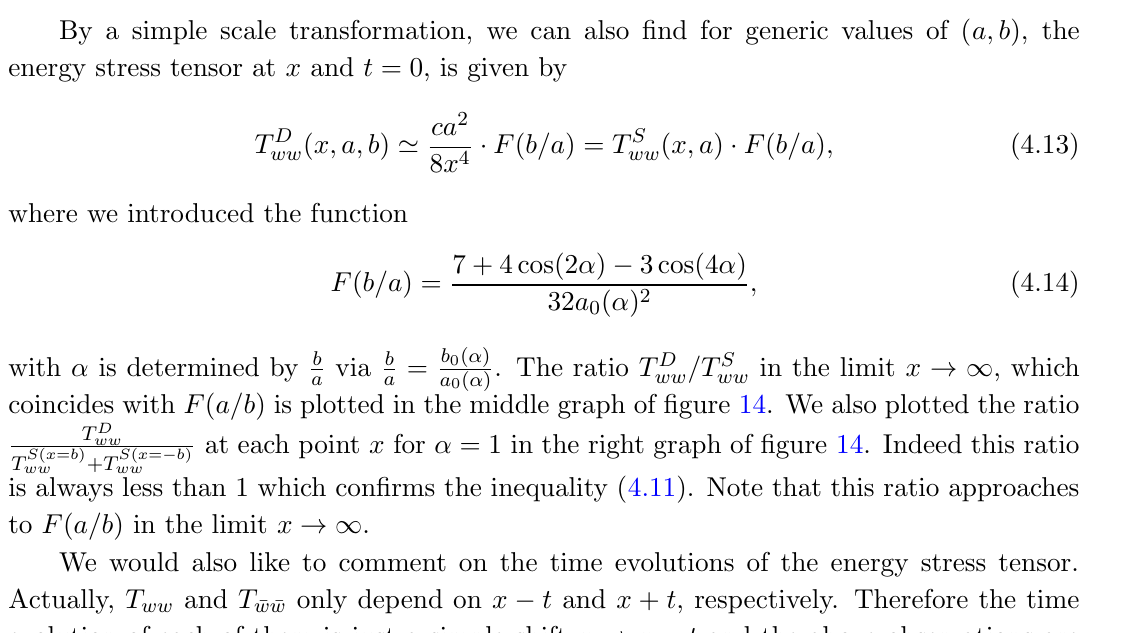
Figure 13 . The above three pictures are the plots of energy stress tensor T (cid:11) = 0 : 001 (left), (cid:11) = 1 (middle) and (cid:11) = 1 : 5 (right). The red graph describes the sum of two single local quenches, while the blue one does the double local quench. In the right graph ( (cid:11) = 1 : 5), the blue and red graph almost coincide. The lower three graphs are the plots of the di(cid:11)erence T D ( T S ( x = b ) ww + T S ( x = (cid:0) b ) ww ), which turns out to be ww (cid:0)